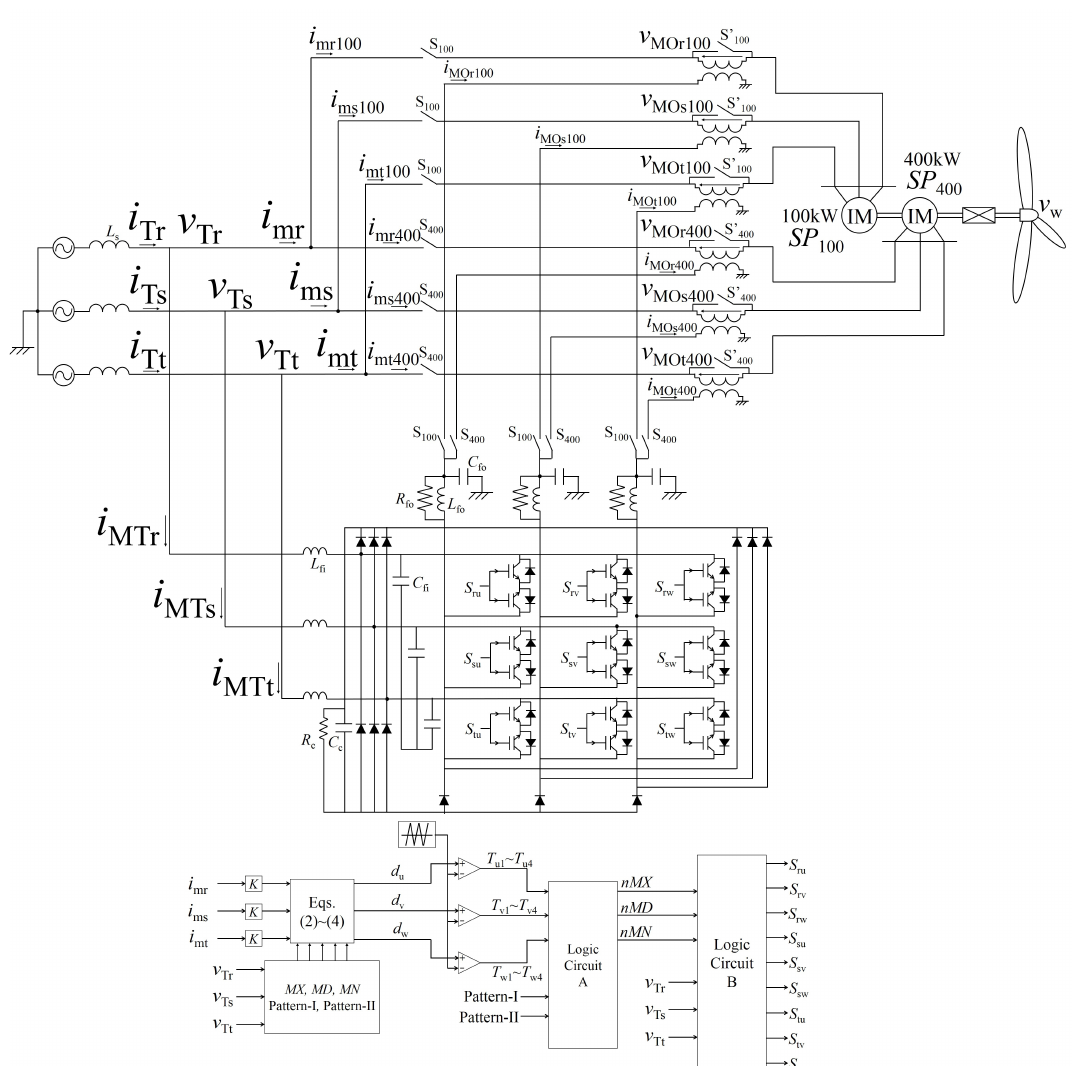
Figure 1. System configuration with the proposed inrush current suppressor using matrix converter (MC) in a large-capacity wind power generation system